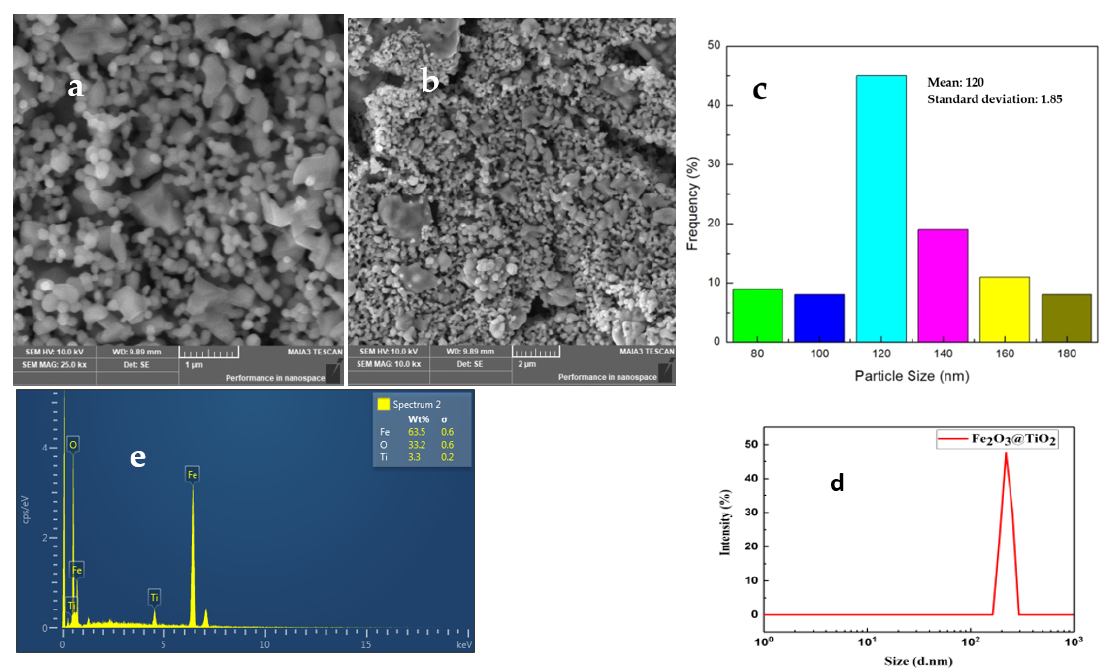
Figure 3. ( a , b ) SEM; ( c ) particle size distribution; ( d ) particle size distribution plot for α -Fe 2 O 3 @TiO 2 ; ( e ) EDX image of α -Fe 2 O 3 @ TiO 2 nanocomposite. Table 1 represents the quantitative elemental composition of the sample as indicated by EDX (Figure 3e) Table 1. Elemental composition details as obtained from EDX.